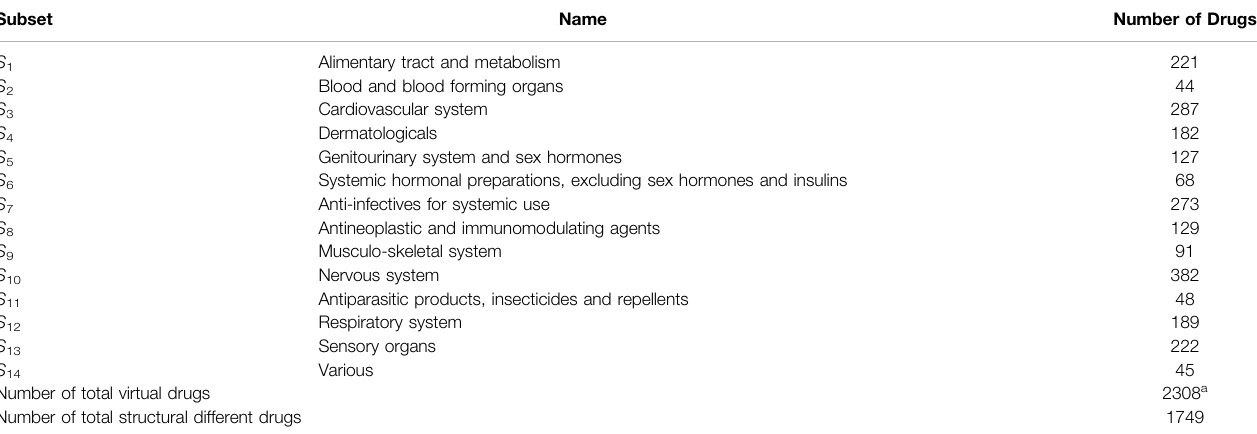
TABLE 1 | The 1749 drug compounds in the benchmark dataset are broken down into 14 ATC classes. Subset